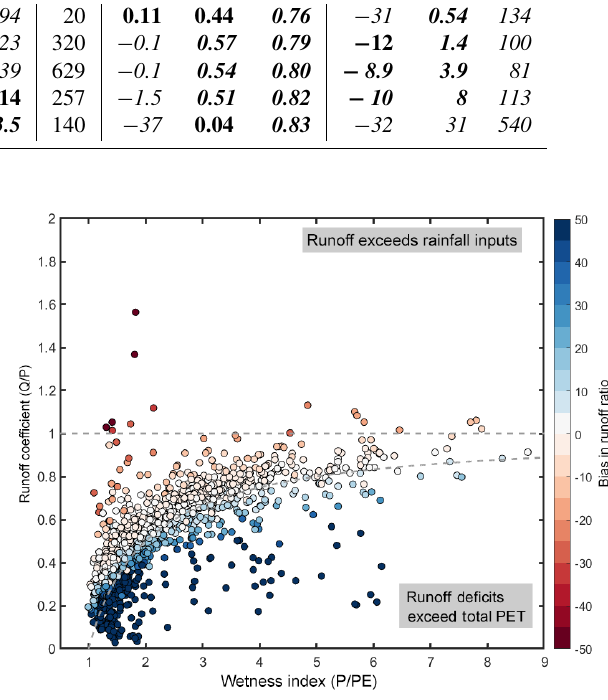
Figure 8. Scatter plot of wetness index (mean annual precipitation divided by mean annual potential evapotranspiration), runoff coef- ficient (mean annual discharge divided by mean annual precipita- tion) and bias in runoff ratio for each GB catchment evaluated in this study. Any points above the horizontal dashed line are where runoff exceeds total rainfall inputs in a catchment, and any points below the curved line are where runoff deficits exceed total potential evapotranspiration in a